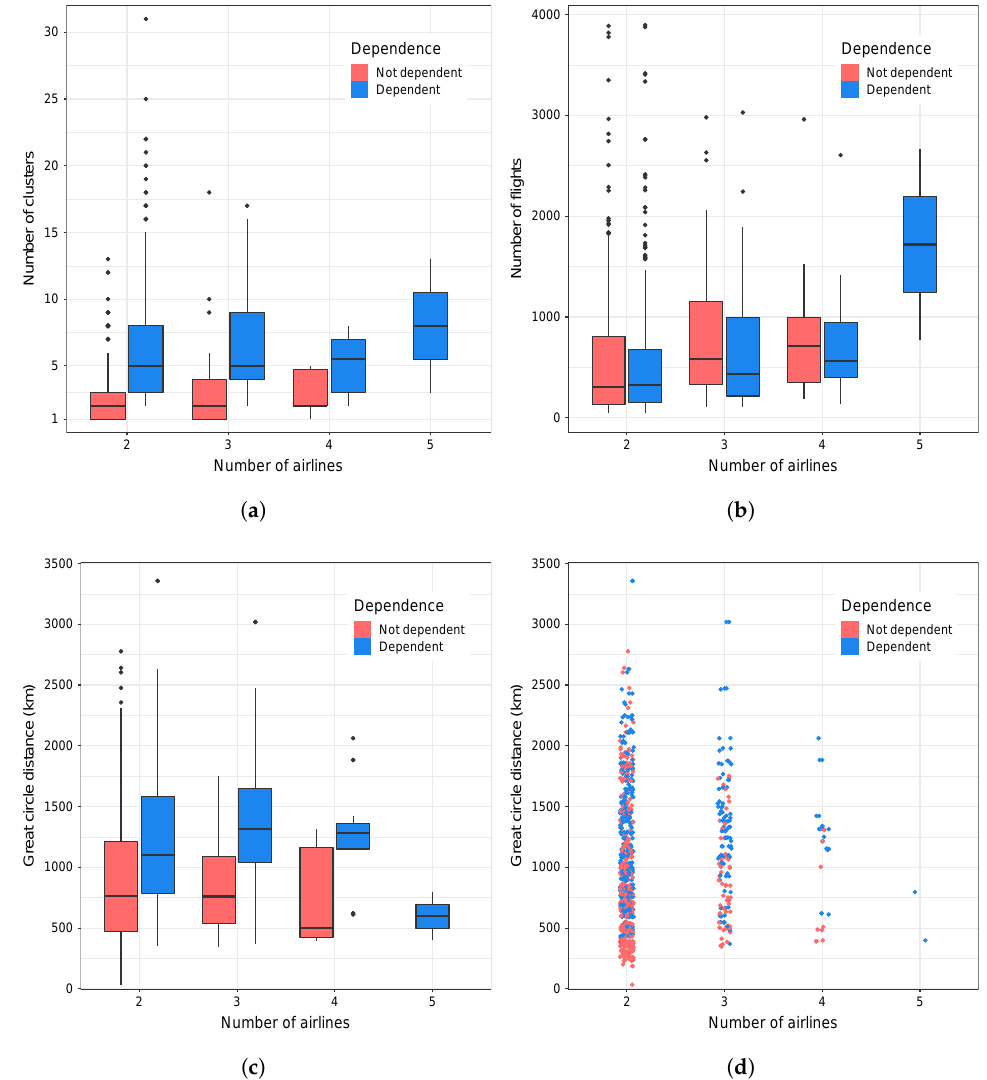
Figure 7. Depiction of the dependence between the airlines and trajectory clusters, and their distribu- tion across number of flights and GCD between ODs. ( a ) number of clusters vs. number of airlines; ( b ) number of flights vs. number of airlines; ( c ) GCD vs. number of airlines; ( d ) GCD vs. number of airlines,